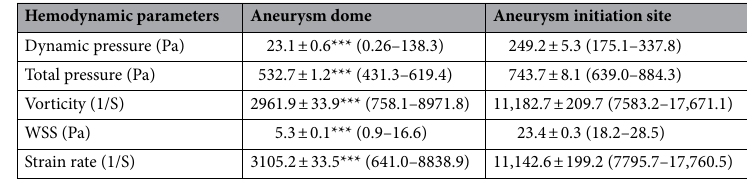
Table 6. Hemodynamic stresses on the aneurysm dome and initiation site after virtual aneurysm removal. *** P < 0.0001, significant compared with aneurysm initiation site after virtual aneurysm removal.